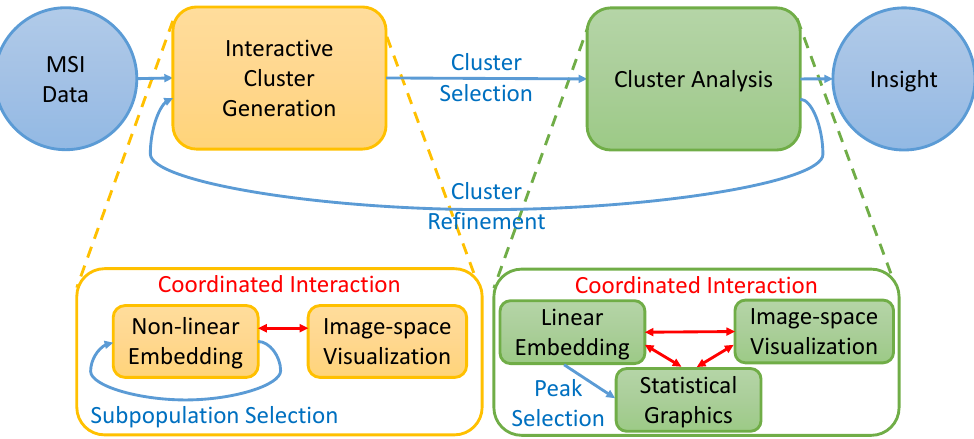
Figure 2. Analytical workflow: Clusters in MS spectra that form image regions are interactively generated and their spectral properties are interactively analyzed. Both steps are performed using coordinated views of (non-linear or linear) embeddings of spectral information and image-space